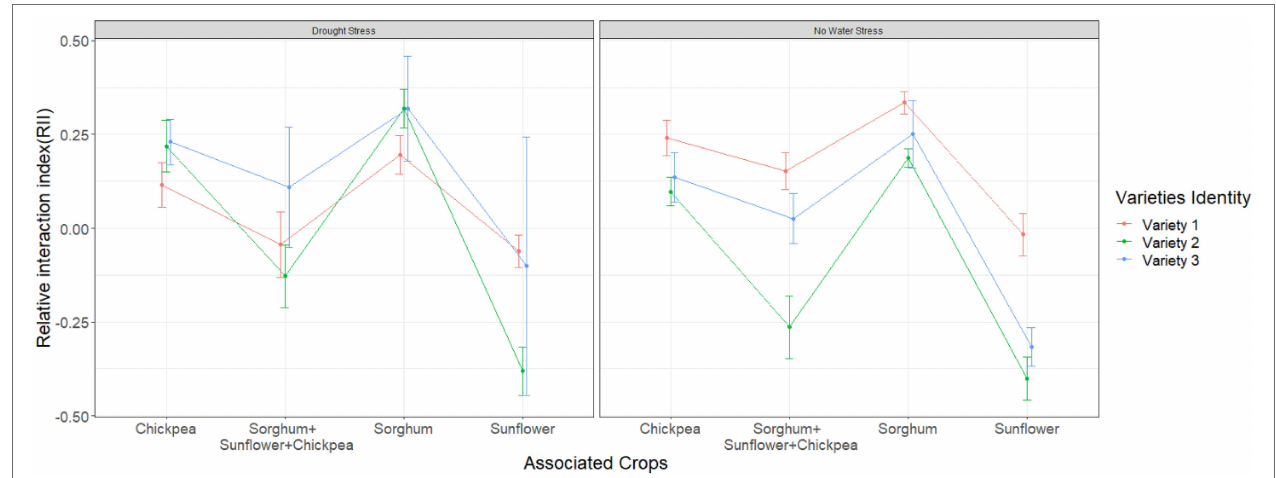
FIGURE 2 | Relative interaction index variation across different varieties in the presence of additional plant species. Error bars represent ±SE.